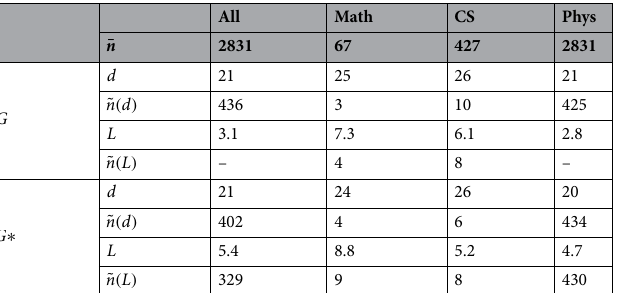
Table 4. Maturation indices and maturation values of the graphs’ diameter and characteristic path length. All notations and definitions are reported in the text. The symbol “–” reflects the fact that the property does not maturate, implying that significant changes in the property’s value occur at all fusion indices, up to the final layer (the reported values are therefore the “asymptotic” ones obtained by fusing all